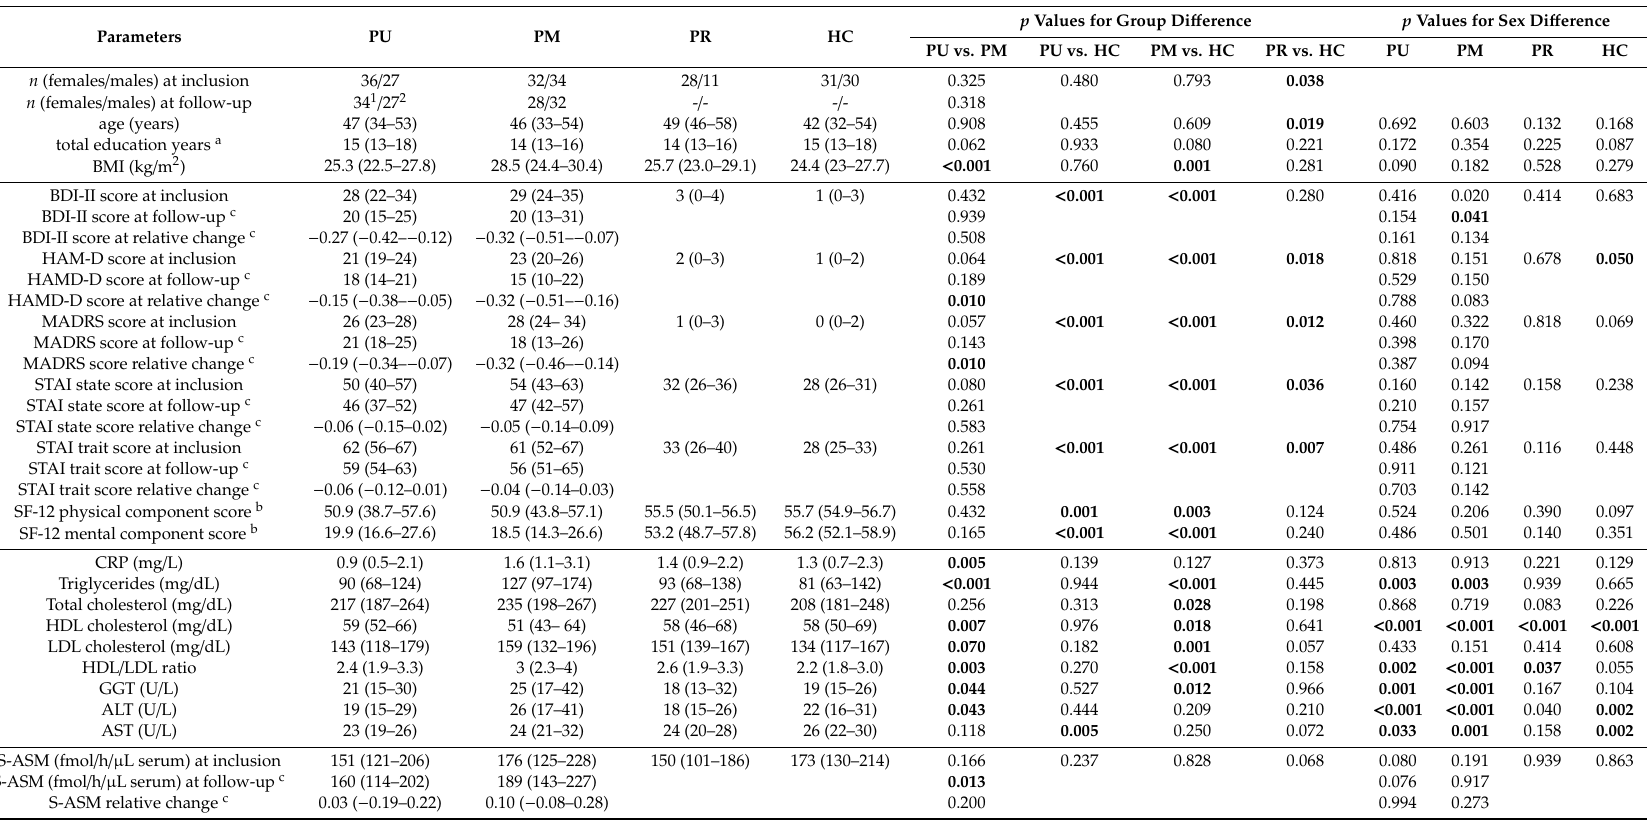
Table 1. Study cohort description and group di ff erences for patients and control subjects at study inclusion and follow-up (3 weeks